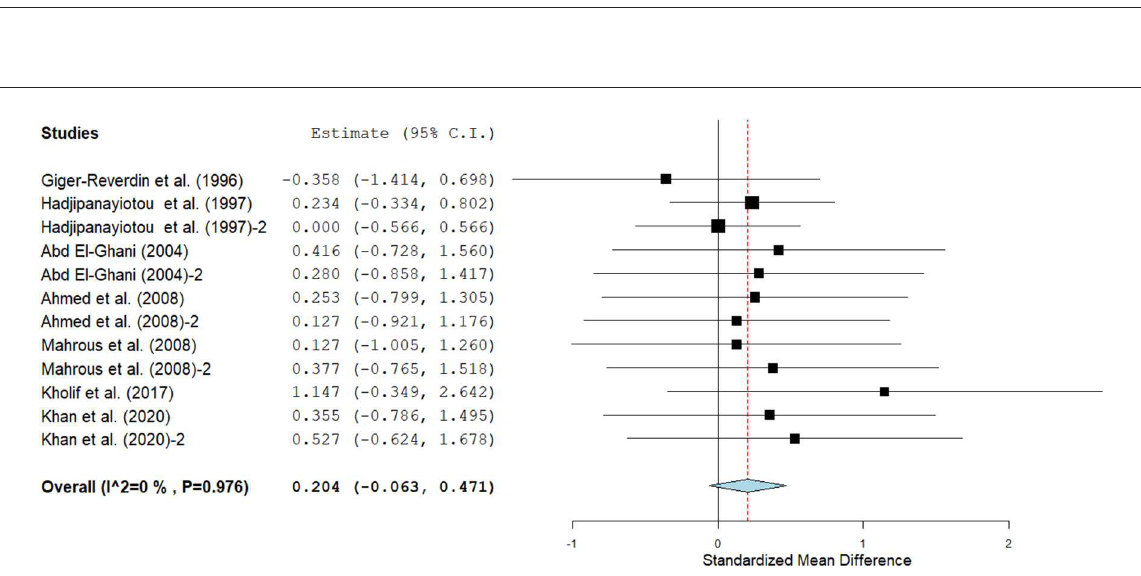
FIGURE7 The effect of SC on milk ash content in lactating goats. The error bars connote the SMD of each trial, while the upper and lower 95% CIs for the effect size are the line that joined the individual square box. The thick vertical line is the line of no effect (SMD = 0), which suggests no effect of SC supplementation on milk ash. The sky-blue diamond at the base of the plot indicates the pooled SMD with its width representing the 95% confidence intervals for the effect size. The points to the right of the line of no effect suggest an increase in milk ash, while the points to the left of the line of no effect connote an increase in milk ash. I 2 is the inconsistency